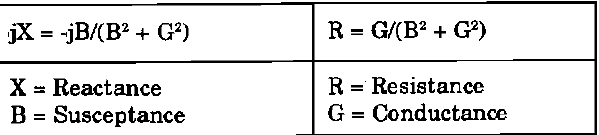
TABLE 1: Formulae to convert admittance (Y) com- ponents to components to impedance (Z) compo- nents (Margolis,